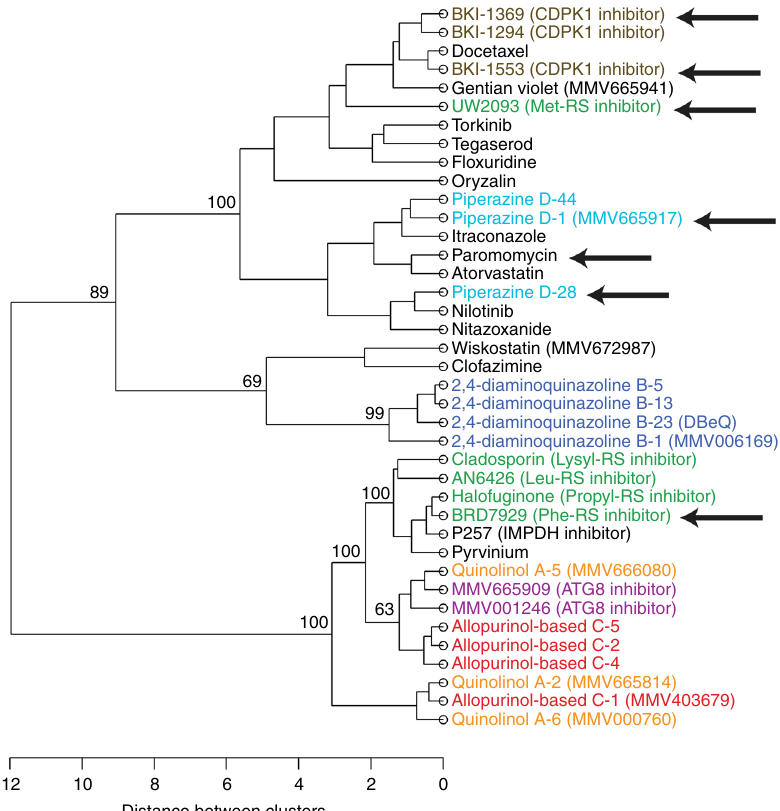
Fig. 7 Dendrogram showing the results of a clustering analysis based on life cycle stage assay data for a diverse set of 39 Cryptosporidium growth inhibitors. Results from the life cycle stage assays were used to calculate a distance matrix using Euclidean distances from the mean control results, and the dendrogram was generated using the Ward error sum of squares hierarchical method. For the major nodes, bootstrap proportions ≥ 60% are shown (1000 bootstrap iterations). Singleton compounds, i.e., those with no known similarity to other compounds in the collection, are shown in black, and others are colored according to chemotype and/or putative mechanism of action. Compound structures and phenotypic assay results for each are shown in Supplementary Fig. 1 and Supplementary Table 2, respectively. NSG mouse ef fi cacy studies performed on 31/39 compounds are summarized in Supplementary Table 3, and compounds with ef fi cacy in the NSG mouse model at the dose tested are indicated with an arrow. Source data are